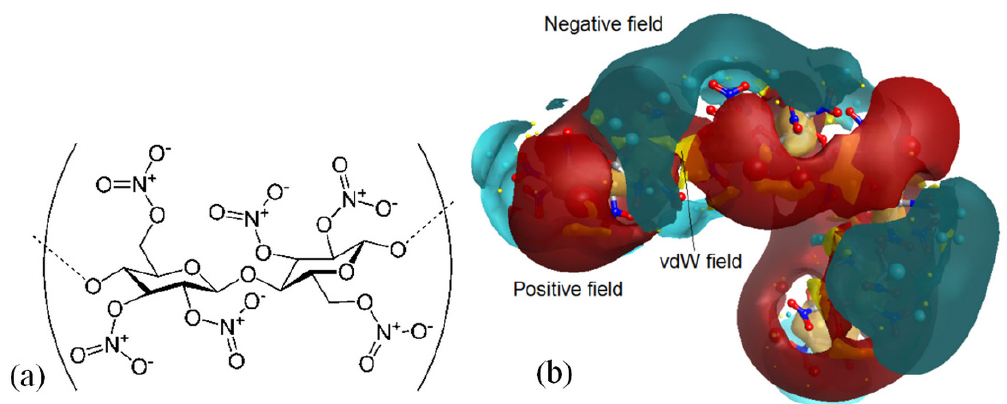
Figure 1. (a) Scheme of nitrocellulose, and (b) fields around a NC chain (calculated using TorchLite 10.0.1 [ 4,5